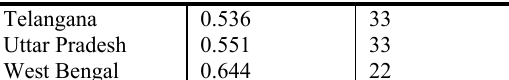
Table 4: Correlation coefficient of the models for nine Indian state and the no of CCE data used for model development The coefficient of determination (R2) for rice yield prediction was found to be significant at 95 % for all the 12 states of India with R 2 varying between 0.35 and 0.87 (Table 4).